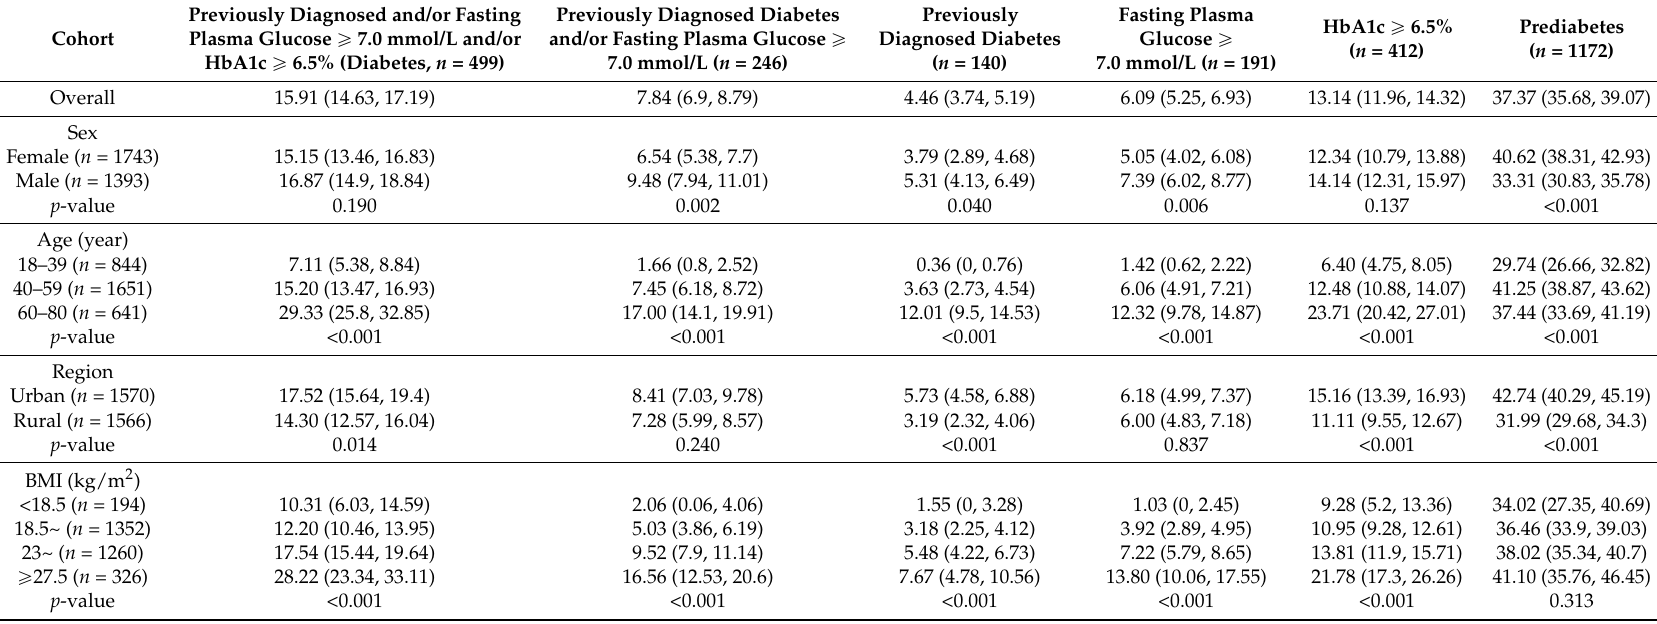
Table 2. Prevalences of diabetes and prediabetes (% (95%